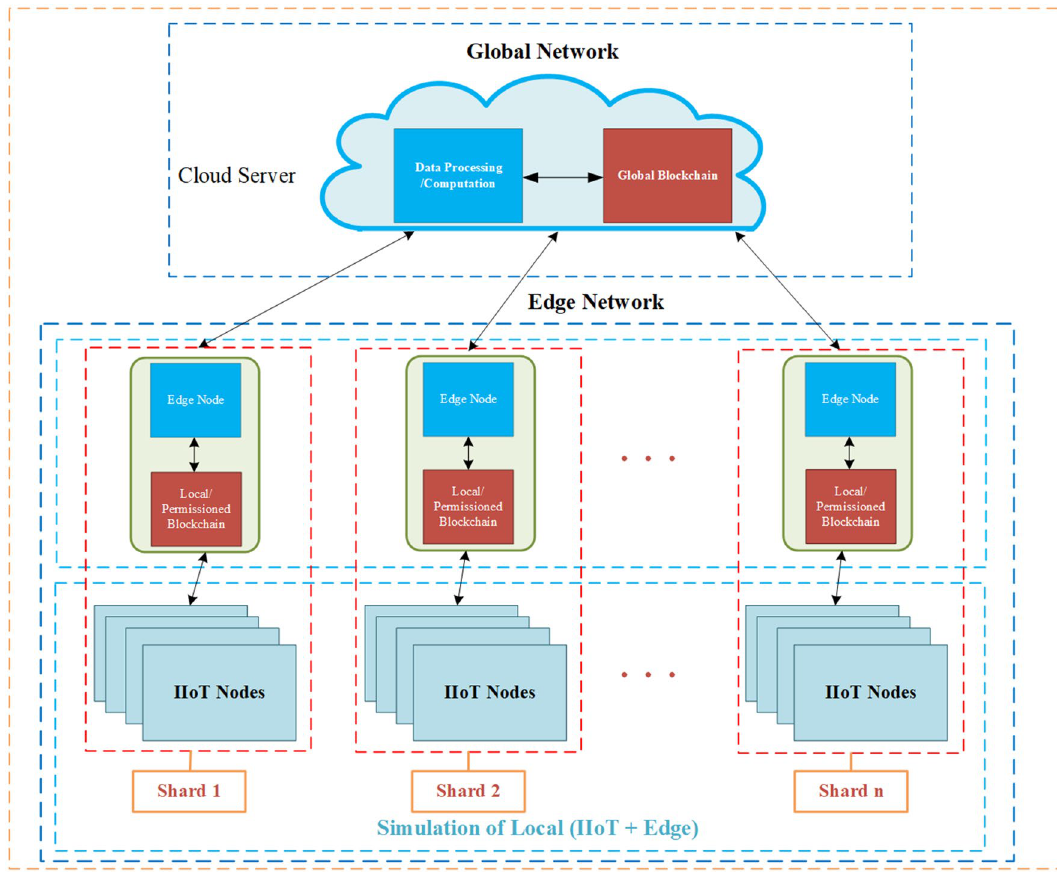
Figure 1. Overall system structure